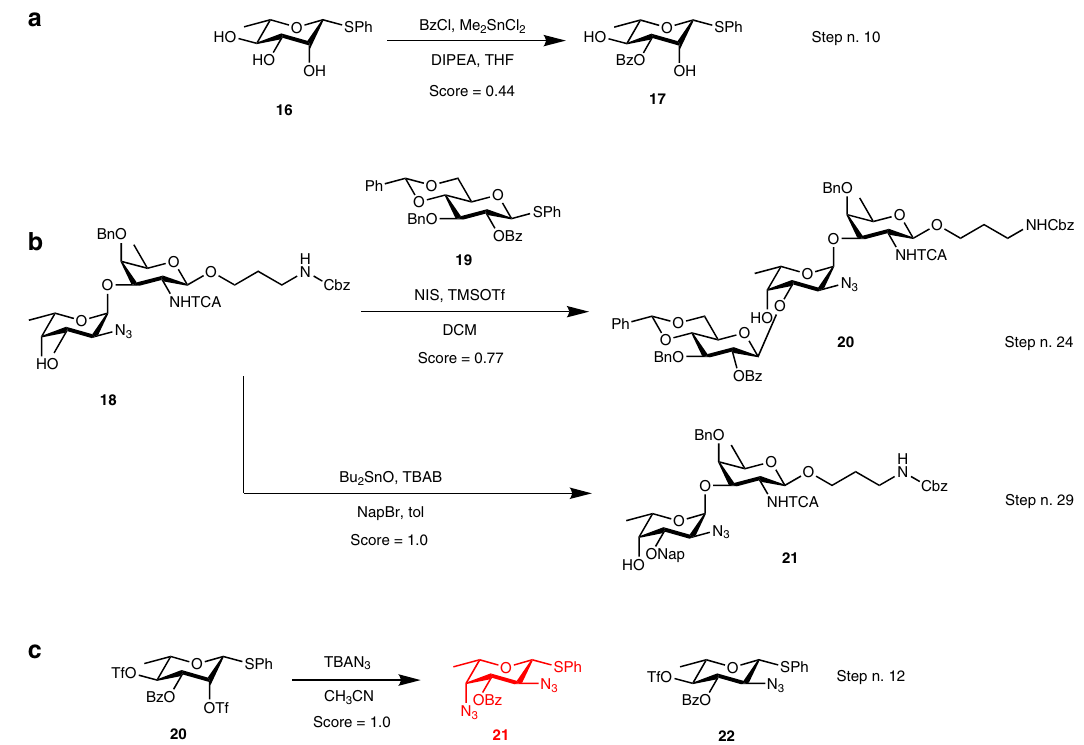
Fig. 5 Reactions predicted from recent literature. a , b Reactions correctly predicted. c wrongly predicted reaction (red structure) due to missing reagent stoichiometry in the model: only one equivalent of NaN 3 was used resulting in single substitution, while the model predicts double substitution.